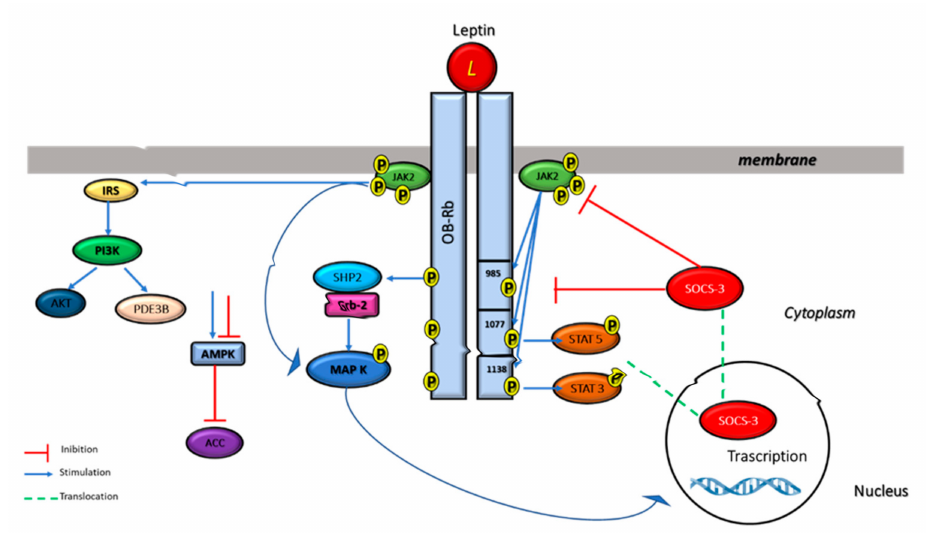
Figure 4. Multiple leptin signaling pathways. Leptin binding to its receptor activates the JAK–STAT3, PI3K, and ERK pathways. For JAK–STAT activation, activated JAK2 tyrosine kinase induces the phosphorylation of Tyr985 and Tyr1138 of ObRb, which results in the activation of STAT3/STAT5. Phospho-Tyr985 recruits SHP-2 and GRB2 resulting in the activation of ERK signaling. Furthermore, leptin activates PI3K by recruiting IRS proteins and it is also able to inhibit AMPK activity. ObRb is the isoform of the leptin receptor that is primarily responsible for leptin signaling [74]. Leptin induces JAK2 activation which leads to the phosphorylation of different tyrosine residues of the ObR, including Tyr985, Tyr1077, and Tyr1138. The